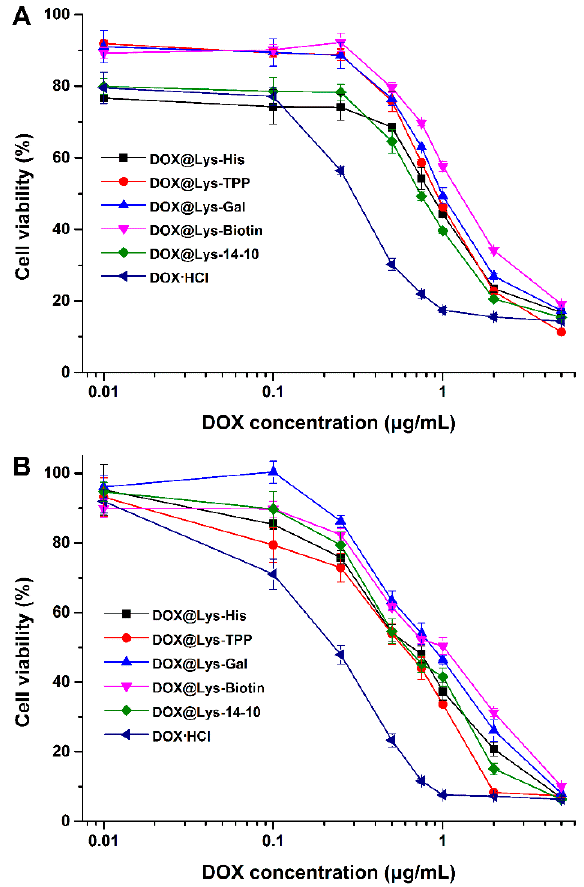
Figure 9. In vitro antitumor effects of DOX-loaded bolaamphiphiles nanoparticles in HepG-2 ( A ) and HeLa ( B ) cells treated with various concentrations DOX-loaded NPs for 48 h. Data represent mean ± SD ( n = 3).